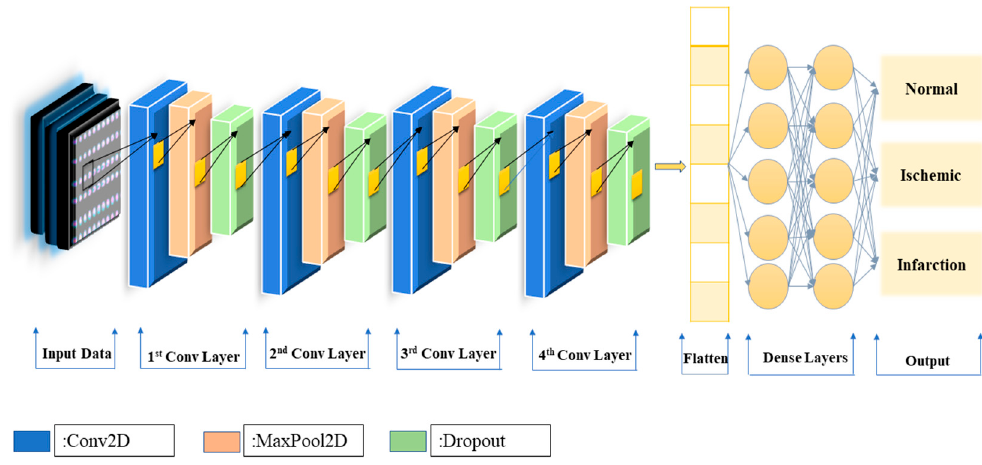
Figure 3. The CNN framework for coronary artery classification.